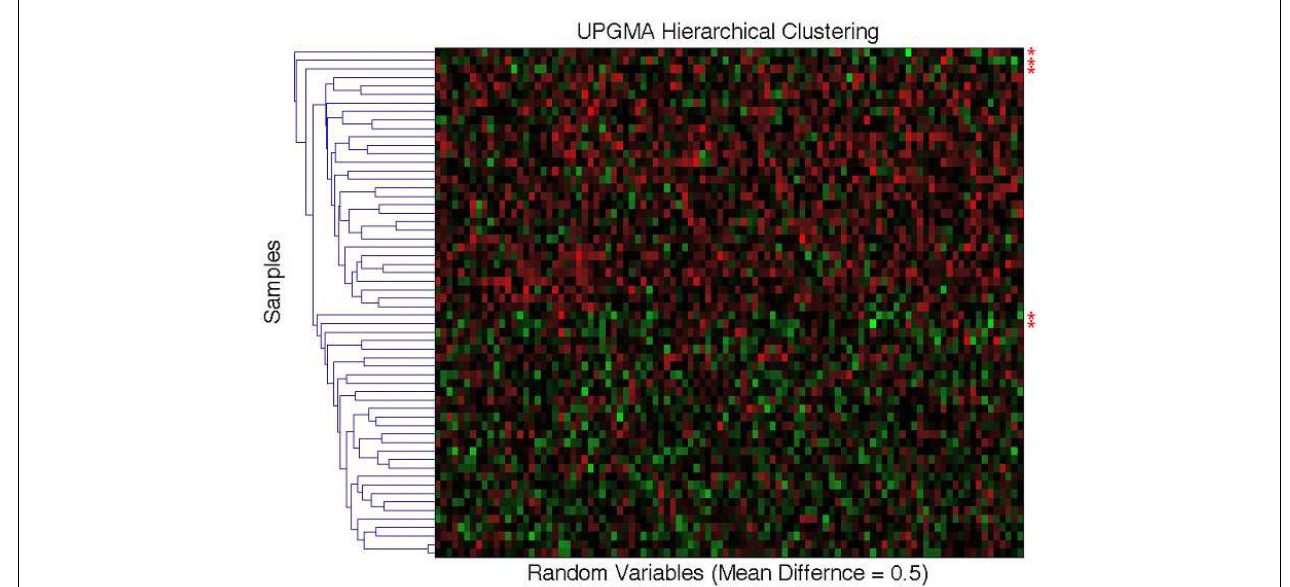
two groups with different means. Shown above are five clusters for what visually appears to be two groups.The red asterisks (*) signify simulated data that has been misclassified.Two samples whose means were at 0.5 were grouped with samples whose means where 0 (bottom two asterisks).The matrix regression technique shows that the correct grouping of two separate groups gives the highest F -statistic of 5.32, while the UPGMA clustering technique of five distinct groups only provides an F -statistic of